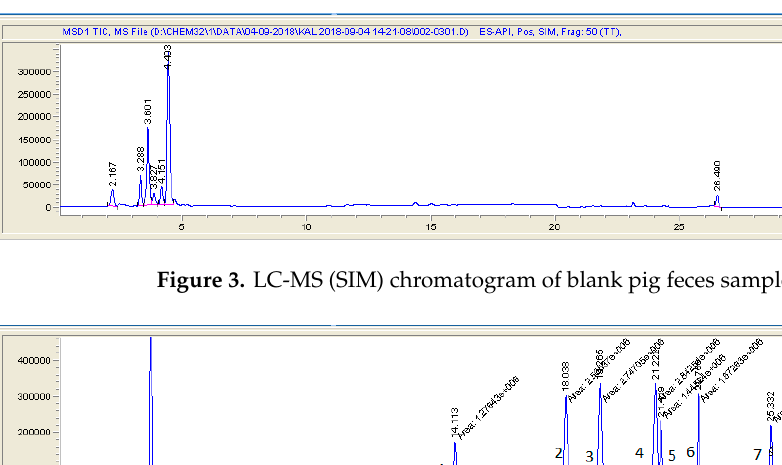
Figure 2. LC ‑ MS/MS MRM chromatograms of spiked pig feces sample with all analyzed compounds at first validation level (trimethoprim—25 µg/kg; oxytetracycline, tetracycline, chlortetracycline, doxycycline, tylosin, tiamulin—100 µg/kg; lincomycin—125 µg/kg; enrofloxacin, ciprofloxacin—50 µg/kg).